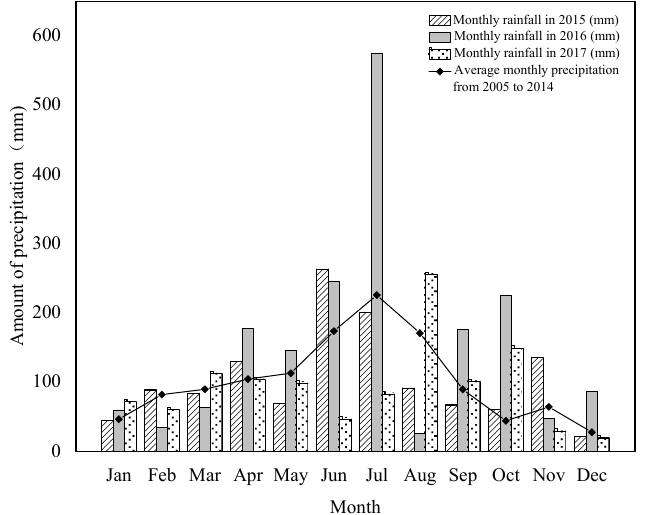
Figure 1. Monthly precipitation from 2015 to 2017 and average monthly precipitation from 2005 to 2014. Table 1. Soil nutrient contents before sowing.